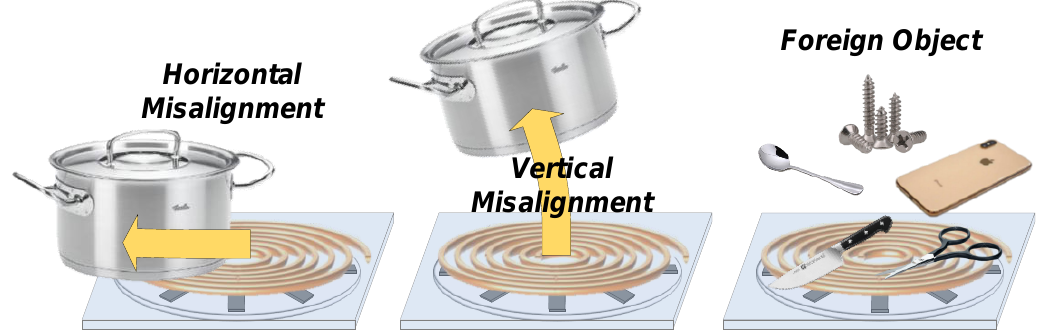
Figure 7. Safety considerations for induction heating.